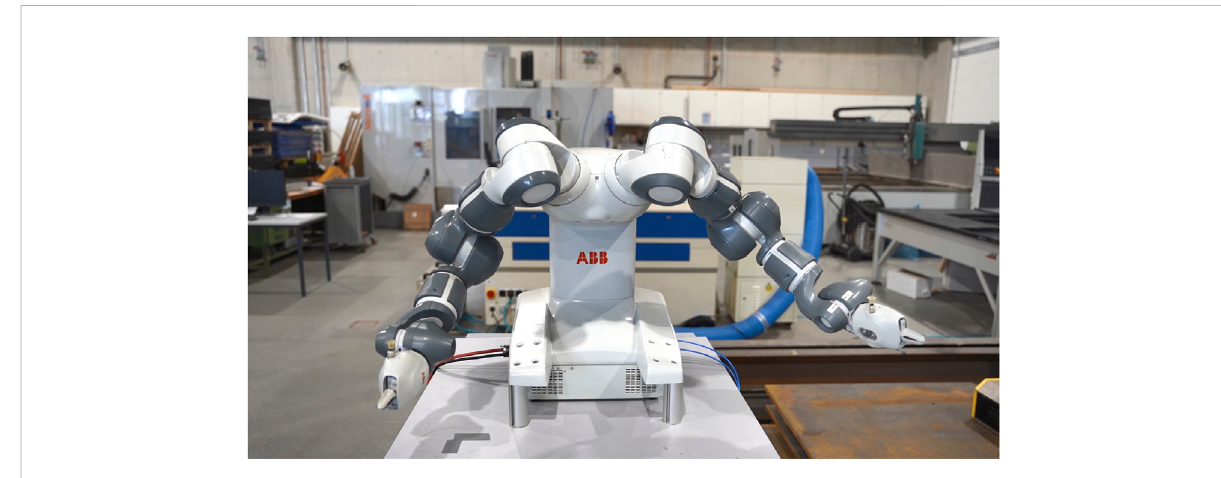
FIGURE 1 The Akimbo gesture where both arms of the robot are placed on the “ hips ” of the dual-arm robot.